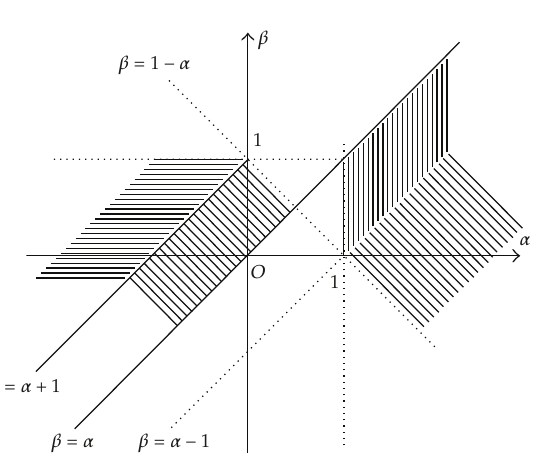
Figure 5: (cid:3) α,β (cid:5) -domain where q α,β (cid:3) t (cid:5) is increasing on (cid:3) −∞ , 0 (cid:5) .